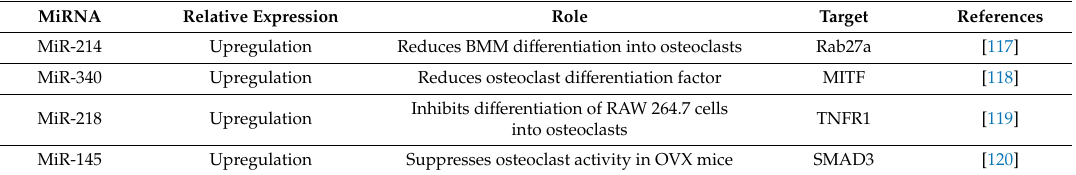
Table 9. MiRNAs involved in osteoporosis osteoclasts.